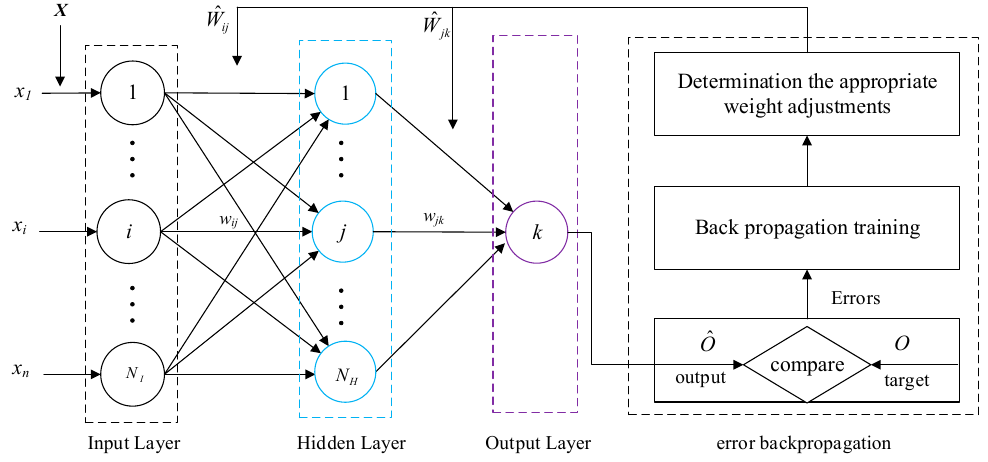
Figure 2. The general structure of BP.